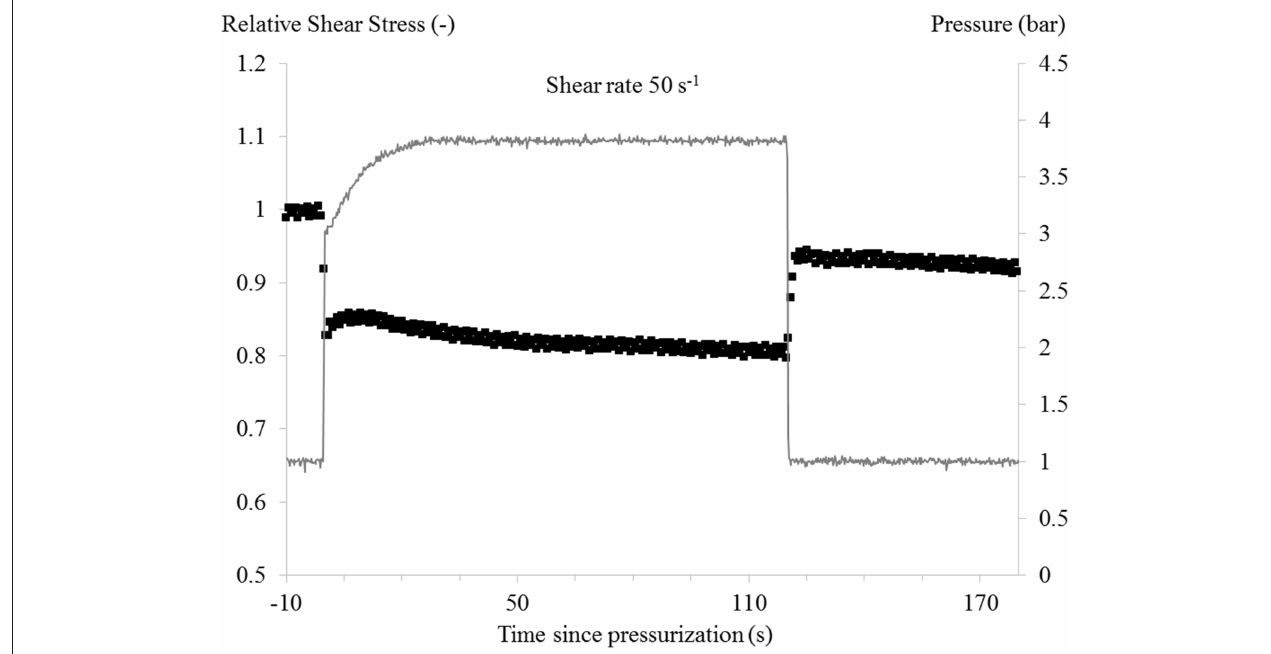
FIGURE 11 | Rate of air dissolution and reappearance at a shear rate of 50 s − 1 .